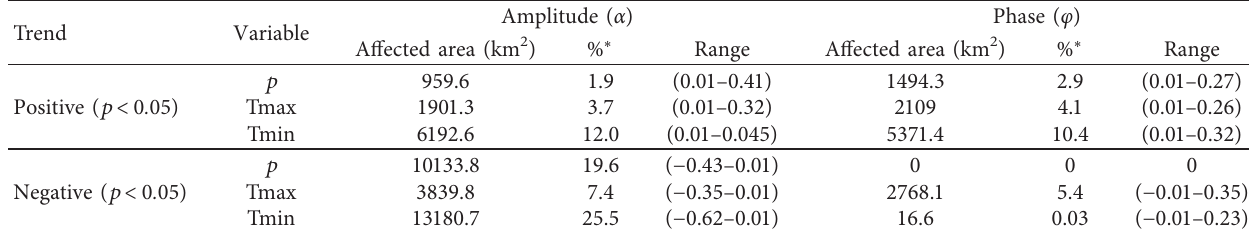
Table 1: Changes in amplitude and phase of climate variables in the LCSB from the initial period (1960–1985) to the final period (1986–2010).